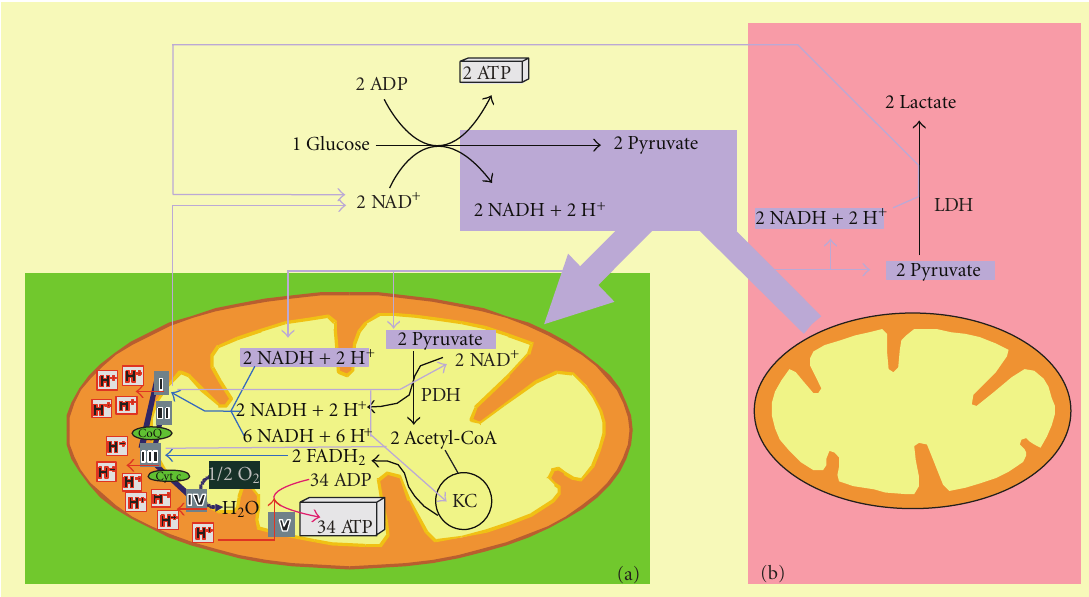
Figure 1: Metabolism of glycolysis-derived NADH and pyruvate in normoxia (a), anoxia and cancer (b). (a) Normoxic normal cells classical- ly oxidize glucose to completion. Cytosolic enzymes convert 1 molecule of glucose to 2 molecules of pyuvate and along with 2 ATP and 2 NADH. Mitochondrial oxidations of glucose-derived pyruvate and NADH involve pyruvate dehydrogenase (PDH), Krebs cycle (KC), and respiratory chain electron transfer/oxidative phosphorylation (OXPHOS) complexes I, II, II, IV, and V, yielding classically 34 ATP. Complete oxidation of glucose therefore results in the production of 36 (2 cytosolic + 34 mitochondrial) ATP. (b) The contribution of mitochondria to glucose oxidation is disrupted in anoxic normal or cancer cells by the arrest of mitochondrial respiration (lack of oxygen in anoxia) and in normoxic and anoxic cancer cells by di ff erent convergent mechanisms. Among these, reduced pyruvate dehydrogenase activity may result from overexpressed pyruvate dehydrogenase kinase 1 and limited access of pyruvate to the mitochondria due to the closed state of mitochon- drial outer membrane voltage-dependent anionic channel (VDAC). Reduced activities of the respiratory chain complexes I and IV and muted Krebs cycle enzymes may be also encountered. Pyruvate, formed intracytosolically from glucose via glycolysis, is no longer oxidized in mito- chondria and is metabolized by cytosolic lactate dehydrogenase. In cancer cells, it must be stressed that the metabolic events mentioned above take place in the context of fuel producing glycolysis in which cytosolic net ATP formation occurs. In turn, the glycolytic flux may be blocked at the pyruvate kinase step (see Figure 4), resulting in biosynthetic precursor-producing glycolysis with little or no net glycolytic ATP or pyruvate production. Cytosolic pyruvate is then provided via other routes (precursors other than glucose) including serinolysis and glutaminolysis, pathways which refer to conversions of serine and glutamine to lactate,